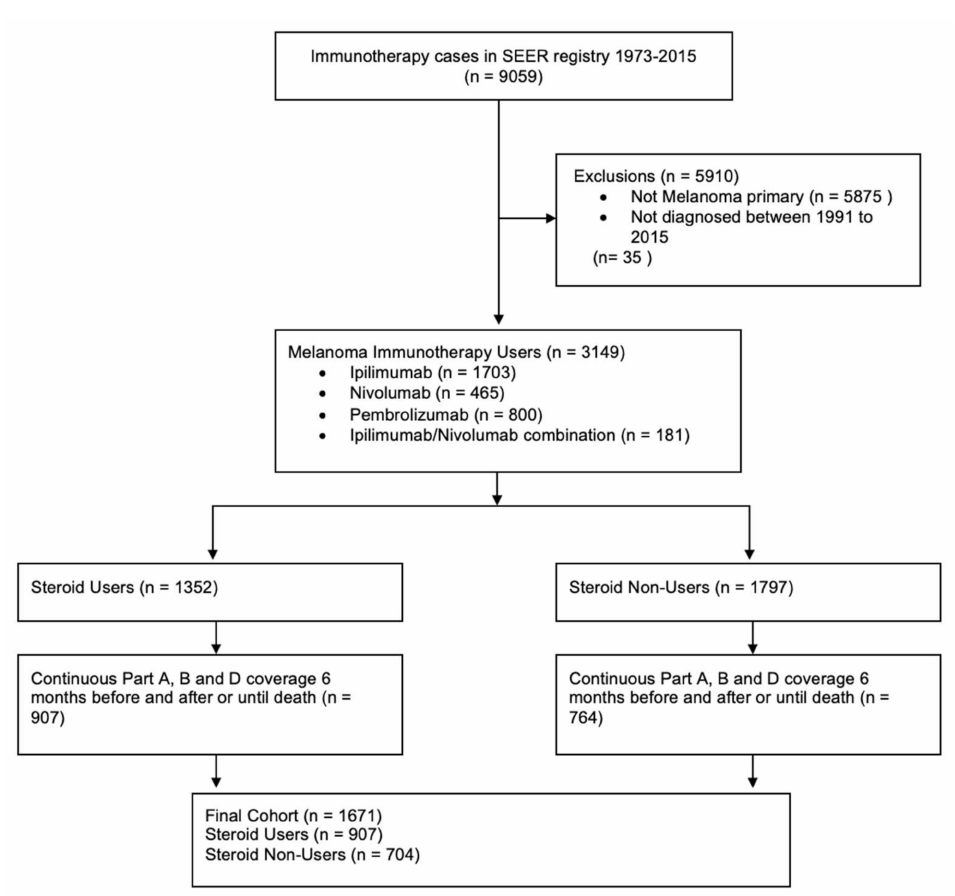
Figure 1. Consort flow diagram. Table 1. Demographic and clinical characteristics of the study sample by steroid-exposure status in the 12 months prior to ICI